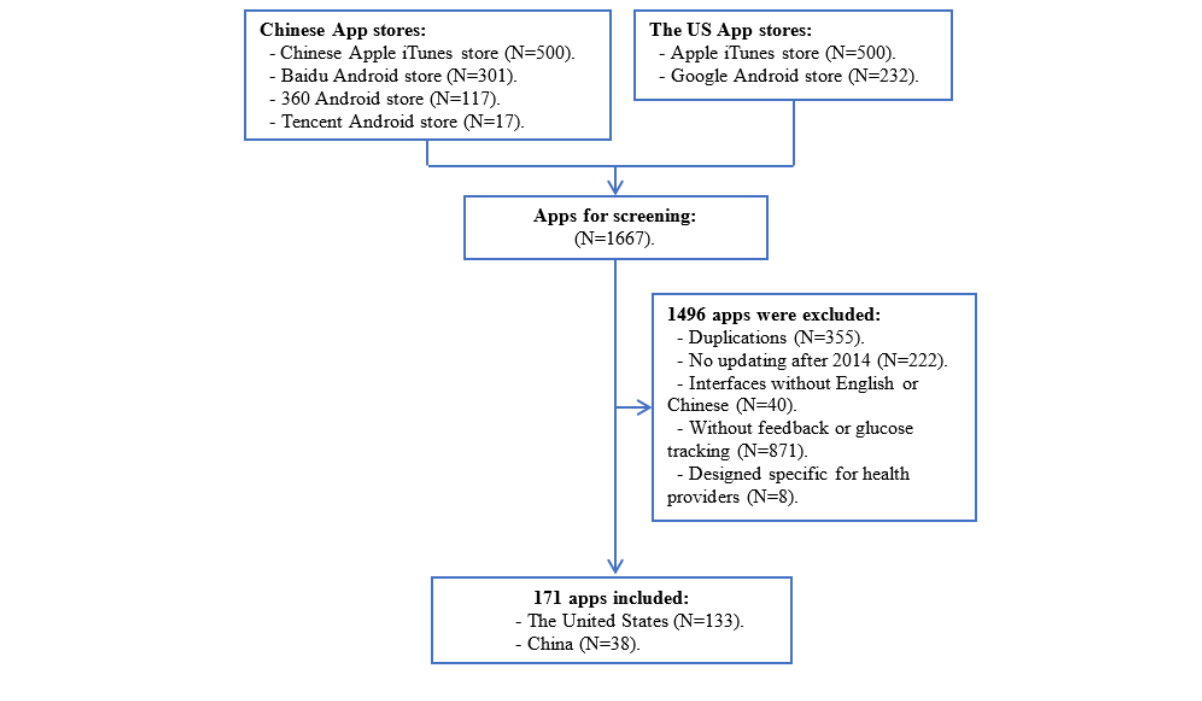
Figure 1. The flowchart of app